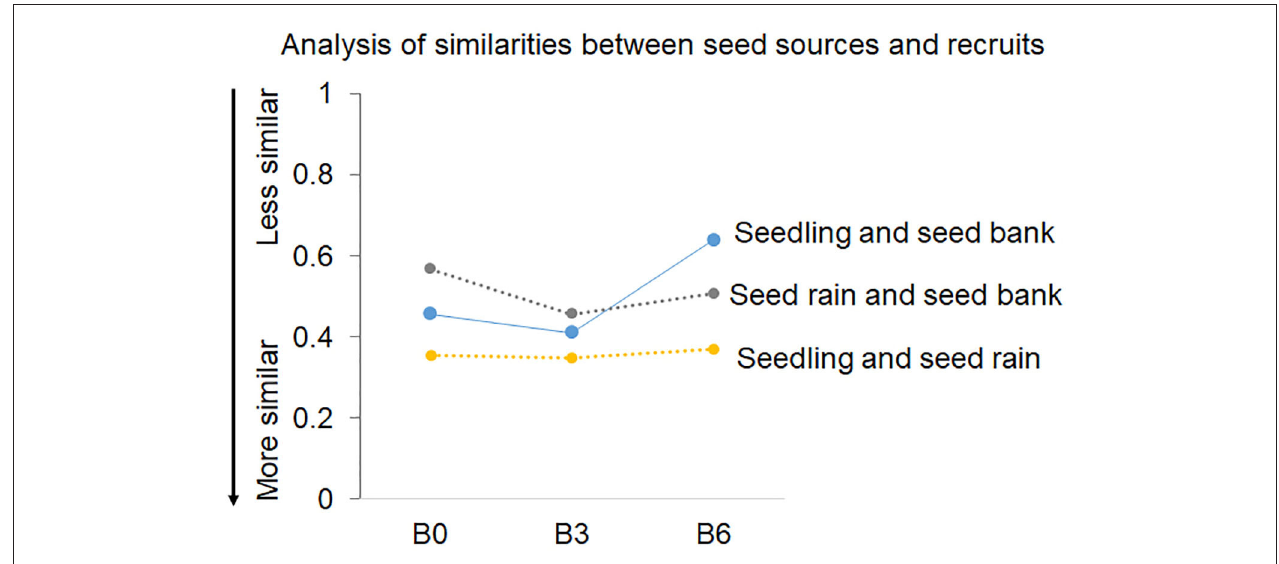
FIGURE 6 | Analysis of similarities (ANOSIM), based on Non-metric multidimensional scaling (NMDS–Bray-Curtis similarity index) comparing the similarities of the structure and species composition of seed source samples (seed rain and seed bank) and seedlings. B0 (control ) was not burned, B3 was burned three times with 3 years interval, and B6 was burned annually, six times.